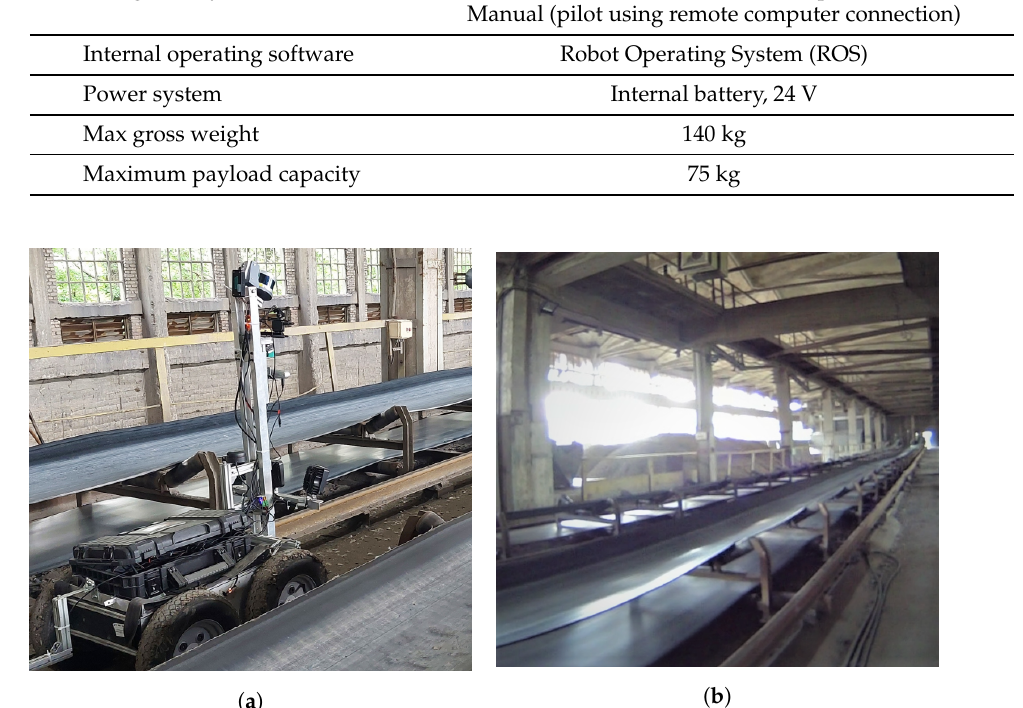
Figure 5. ( a ) Mobile robot during inspection. ( b ) A general picture of the mining